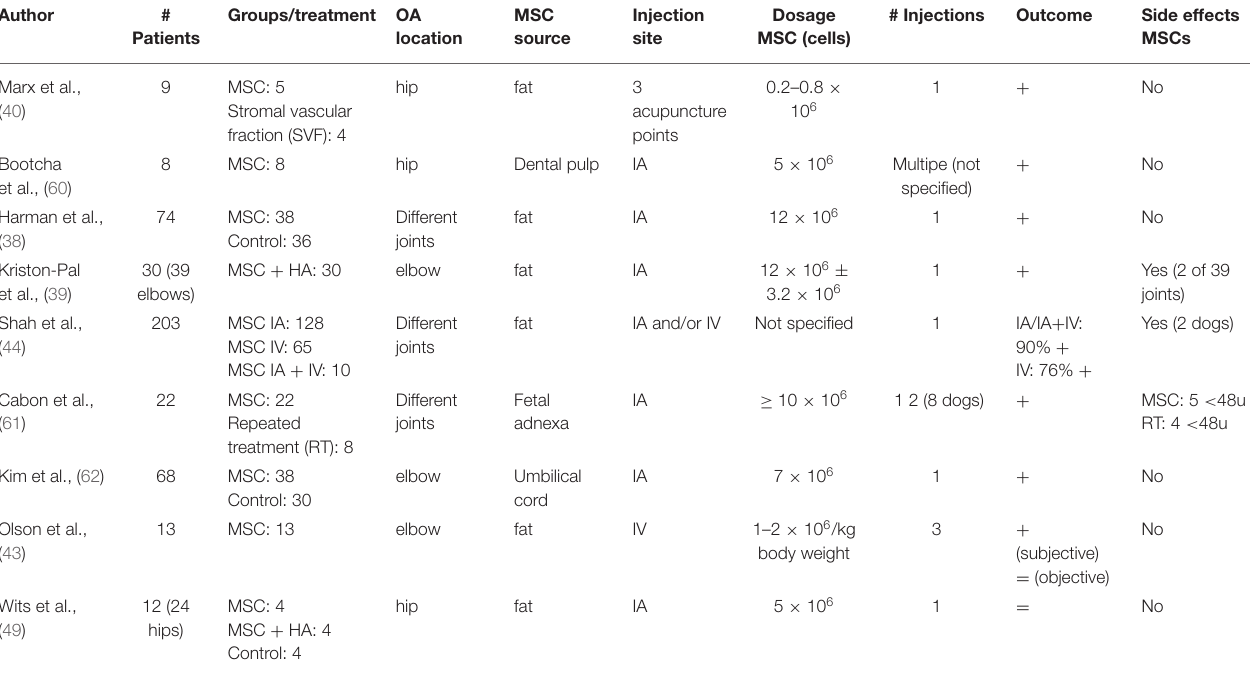
TABLE 2 | Chronologic presentation of studies on naturally occurring OA applying allogeneic MSC.